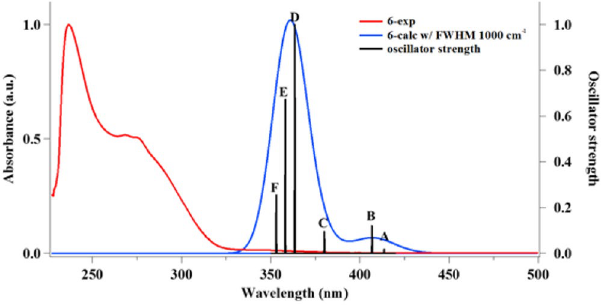
Figure 3. UV-Vis absorption spectrum of Au(III) complex, 6 , in PBS at the concentration of 50 μ M. DMSO was used for stock solution (red) and theoretical spectrum (blue) and oscillator strengths, f , from Table 1 for 6 (black).